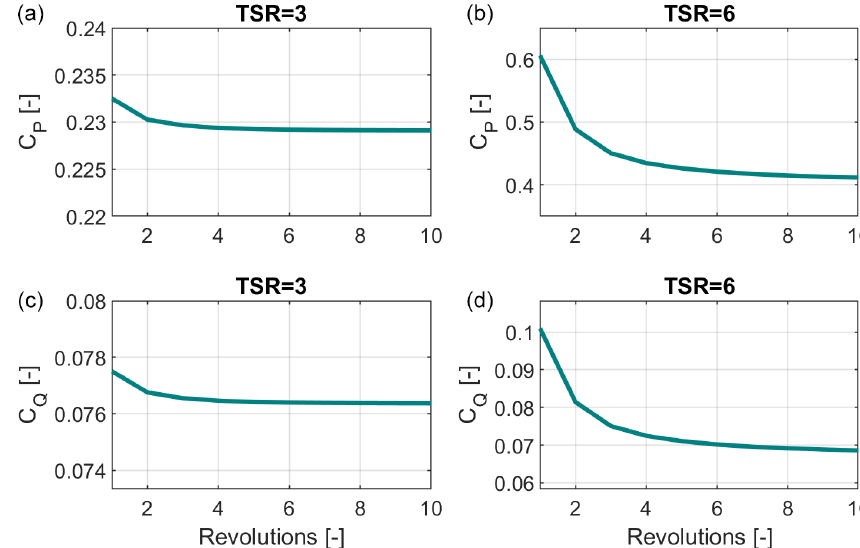
Figure 2. Revolution-averaged performance for 10 revolutions at TSR = 3 (a, c) and TSR = 6 (b, d)